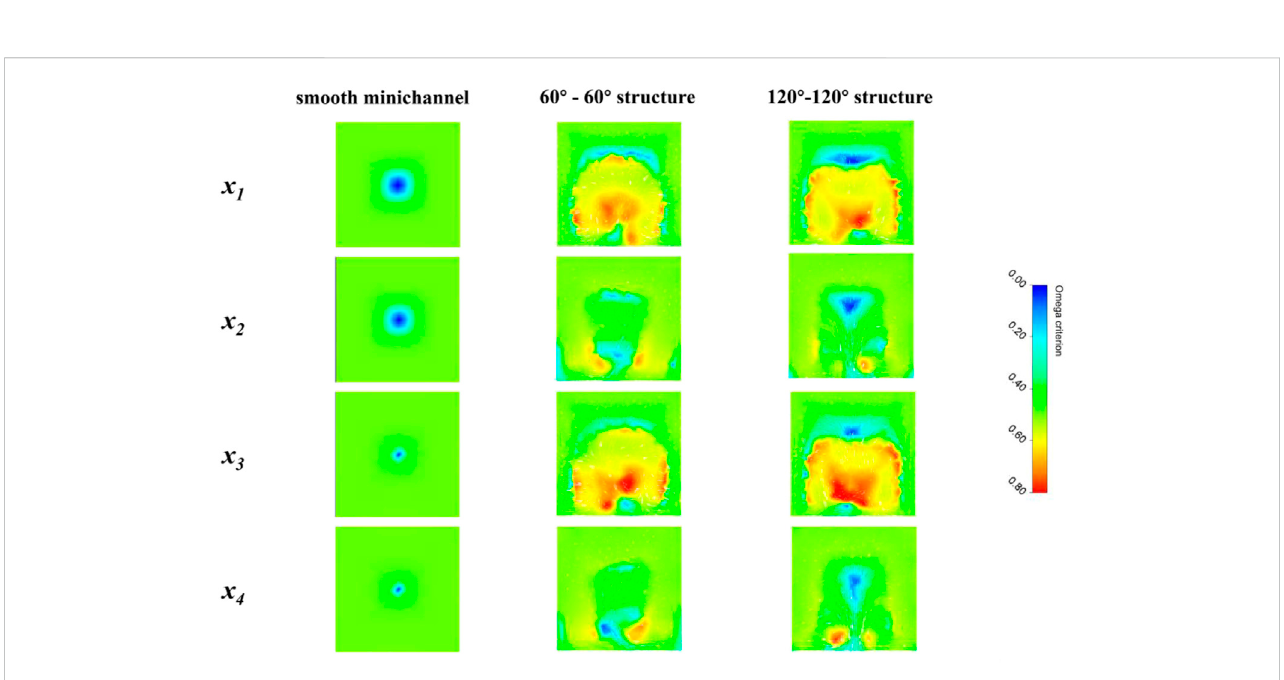
FIGURE 10 Contoursofomegacriterionvaluesondifferentspanwisecross-sectionsfordifferentminichannelcon fi gurations:x 1 =19mm;x 2 =20.5mm;x 3 =37mm; x 4 = 38.5